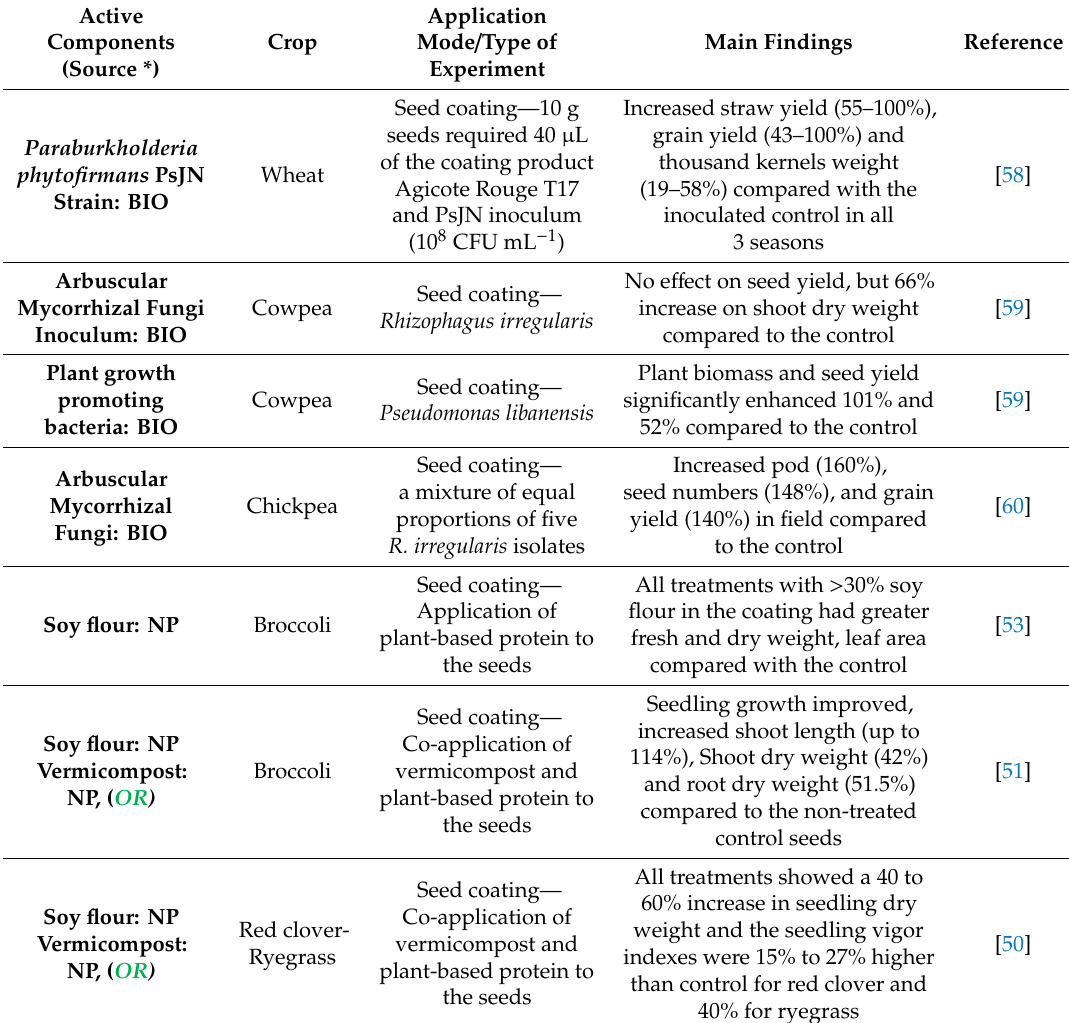
Table 3. Review of biostimulants applied as seed treatments on seed germination, seedling growth and other measured